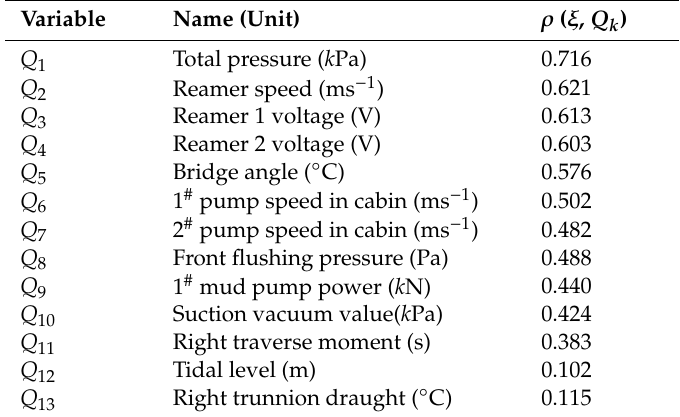
Table 1. Indirect measurements for solid concentration (SC) from other